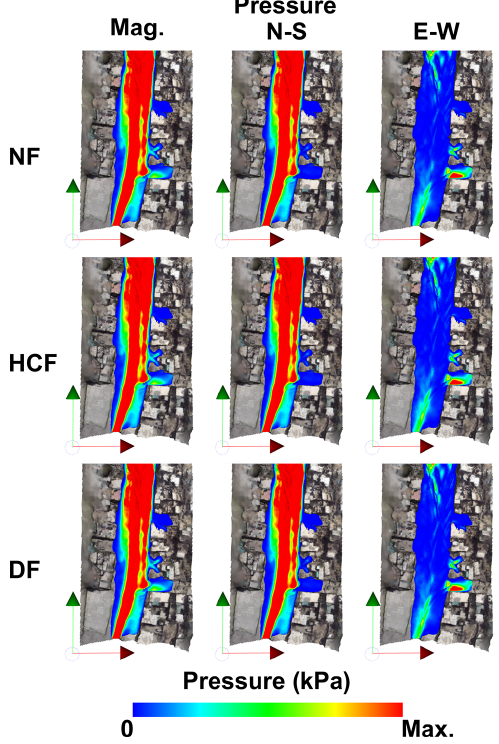
Figure 6. Directional components of dynamic pressure for a 75m 3 s − 1 flow along Quebrada Dahlia for a Newtonian flow (NF), hyperconcentrated flow (HCF) and debris flow (DF). Maximum pressure is 25kPa for magnitude and N–S pressures, 1kPa for E–W pressure.